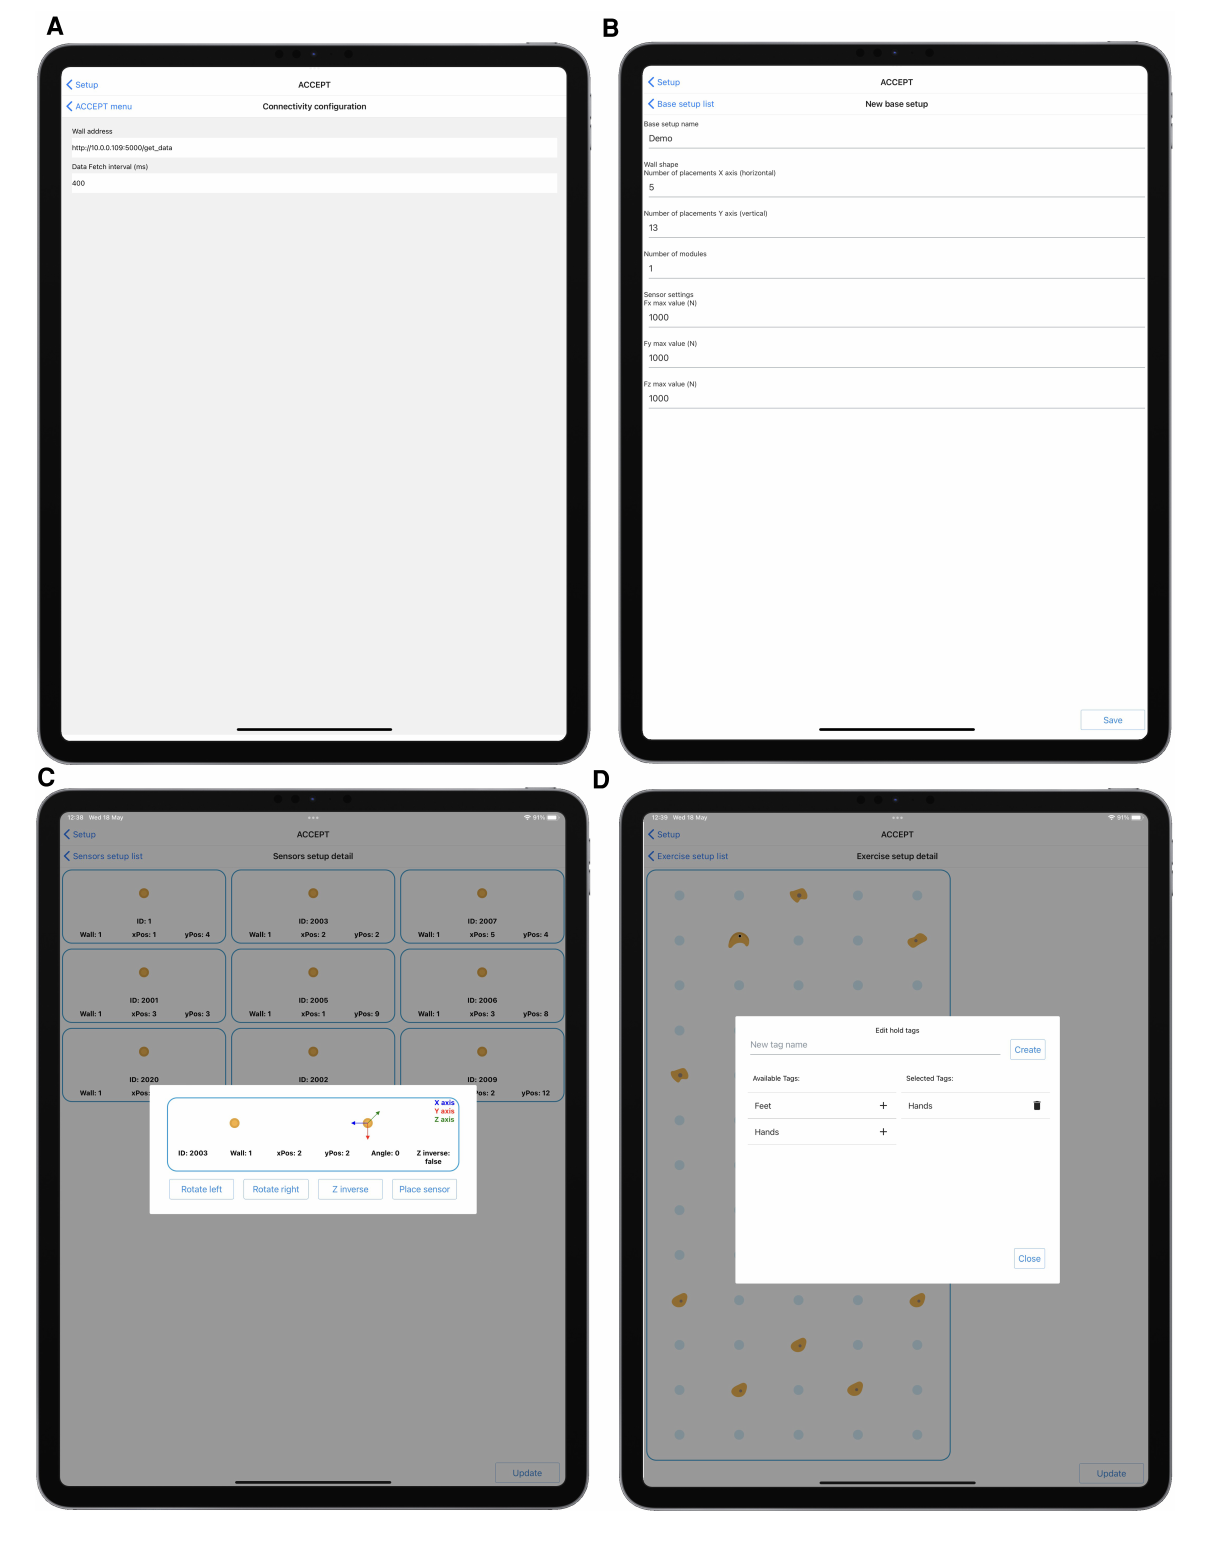
FIGURE 3 Setup environment. ( A ) wall address setup; ( B ) wall geometry setup; ( C ) association of sensors to placements on the wall grid; ( D ) de fi nition of hold tags and selection of holds that compose a climbing problem. In panel ( C ), the position coordinates of the placements originate in the lower left corner, position (1 , 1) being the lower left placement; xPos is the horizontal position, yPos the vertical one. Once a hold is placed on the grid, the same environment displays a virtual representation of the wall and allows the user to assign a shape to the hold, chosen from a menu of pre-de fi ned shapes. This step of the setup is not depicted in the fi gure, but the virtual representation that ensues is visible in panel ( D